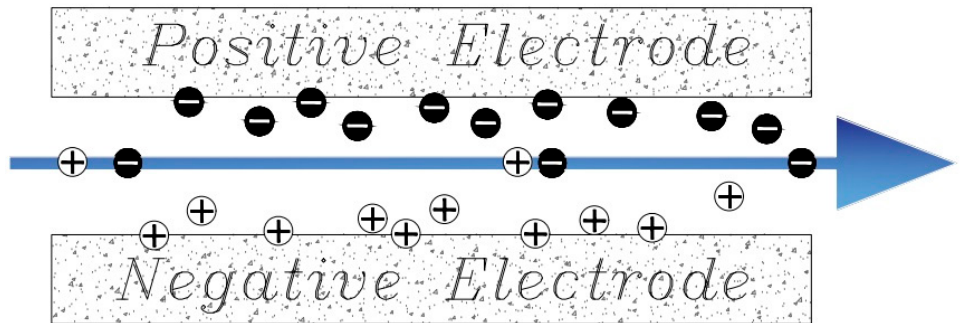
Figure 3. Flow-By method in water desalination by CDI method.